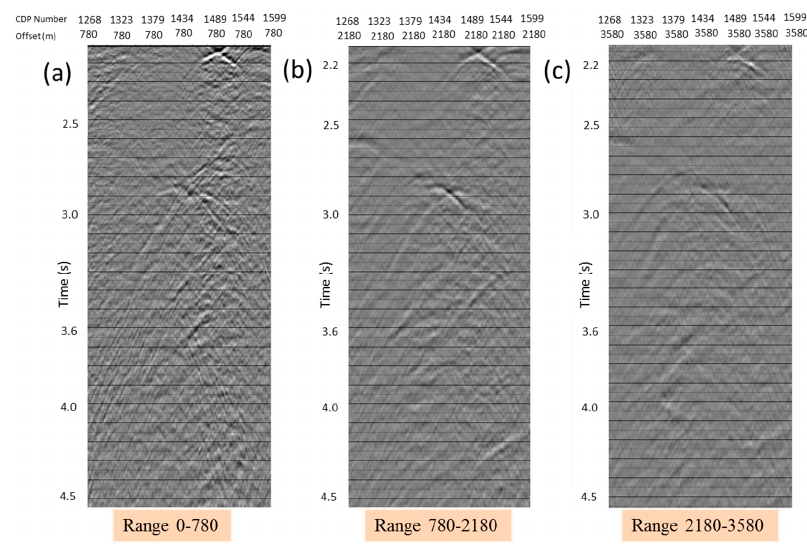
Figure 11. Amplitude decay with offset is recorded at (a) 0 to 780 m, (b) 780 to 2180 m offsets, and (c) a 2180 to 3580 m offset stack; the signal–noise ratio and amplitude is stronger in the near offset.